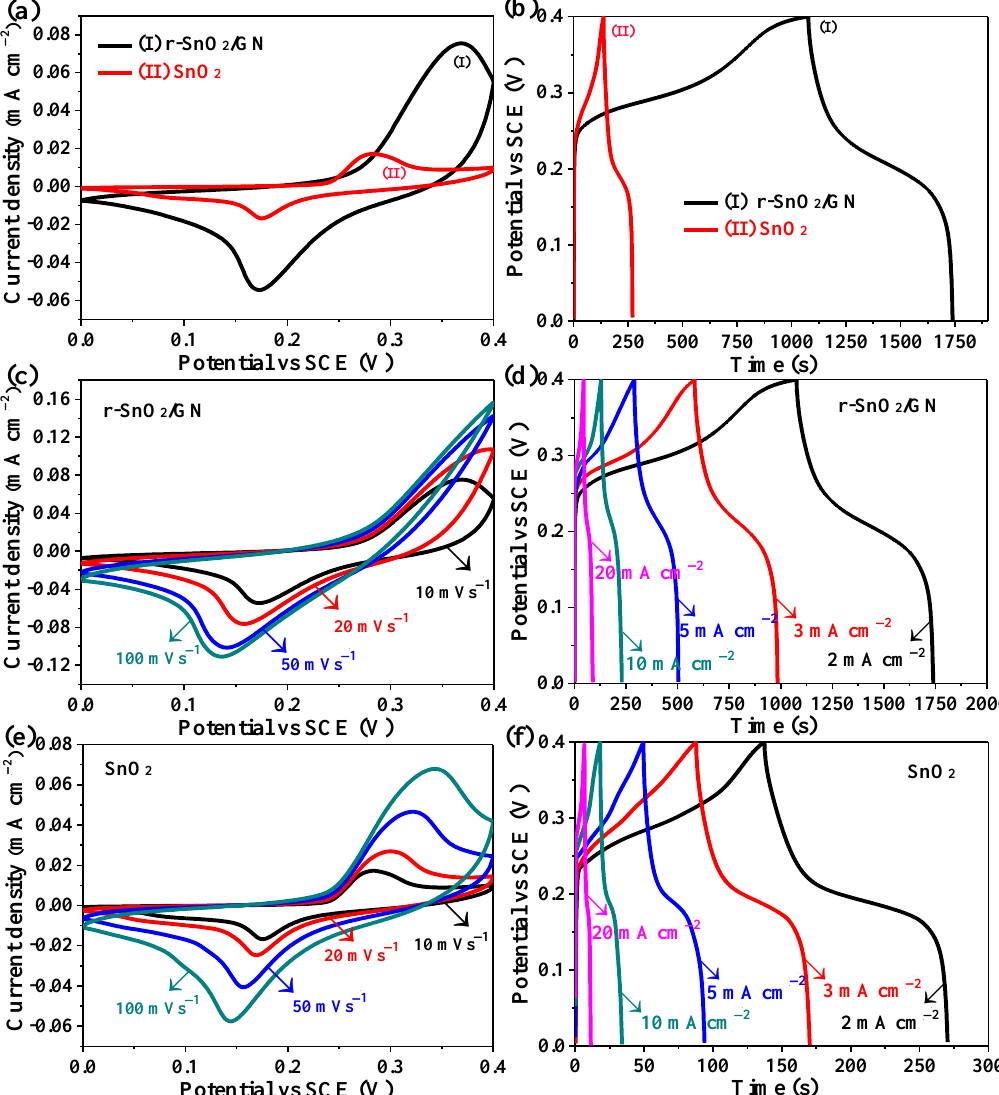
Figure 6. ( a ) CV curves of two electrodes measured at a scan rate of 50 mVs −1 ; ( b ) GCD curves of two electrodes tested at a current density of 2 mA cm −2 ; CV curves for electrodes ( c ) r-SnO 2 /GN and ( e ) SnO 2 measured at various voltage sweep rates; GCD curves for electrodes ( d ) r-SnO 2 /GN and ( f ) SnO 2 measured at various current densities.